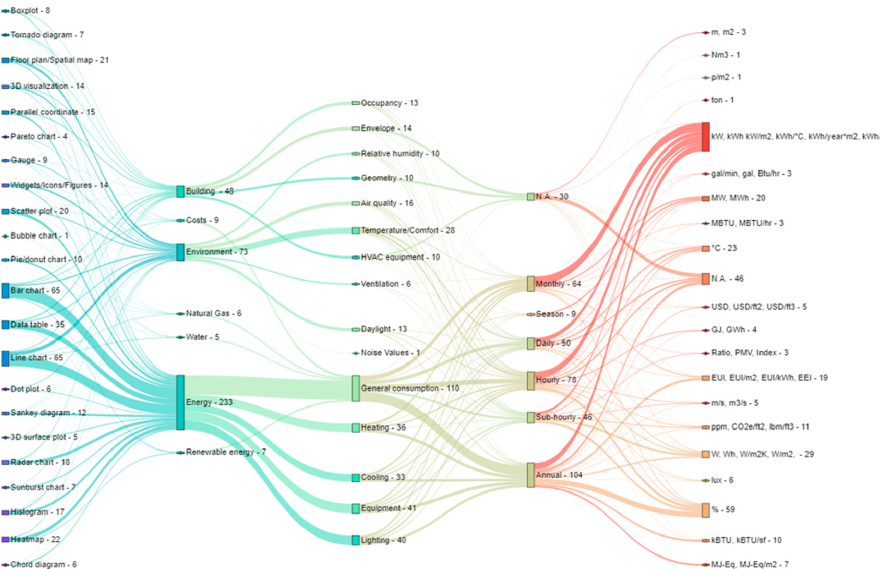
Figure 5. Relationship and trends between visualization types, energy performance indicators, time-scale, and units of measurement. The values indicate the number of occurrences found.